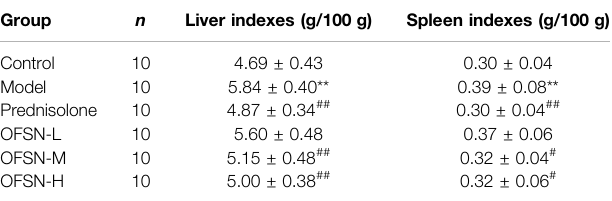
TABLE 8 | Effects of OFSN on liver and spleen index in mice ( ‾ x ± s).